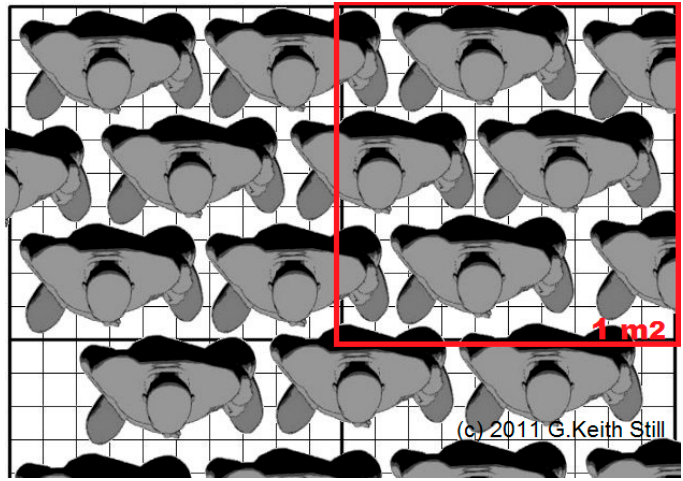
Figure 15. Picture from [30]: example of 5 standing people (adults) per square meter (red box), top view.